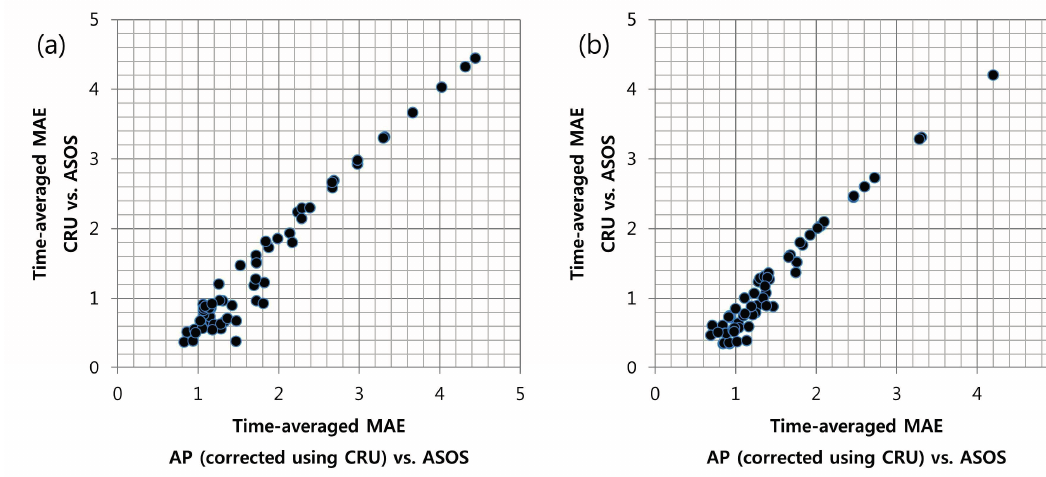
Figure 9. Scatter-plots comparing MAE values averaged for 2002–2011 for ( a ) monthly maximum air temperature during JJA (unit: °C); and ( b ) monthly minimum air temperature during JJA (unit: °C). The x-axis is for MAE between AP corrected using CRU versus ASOS observation data, y-axis is for MAE between CRU gridded dataset versus ASOS observation data; each point represents ASOS weather station’s